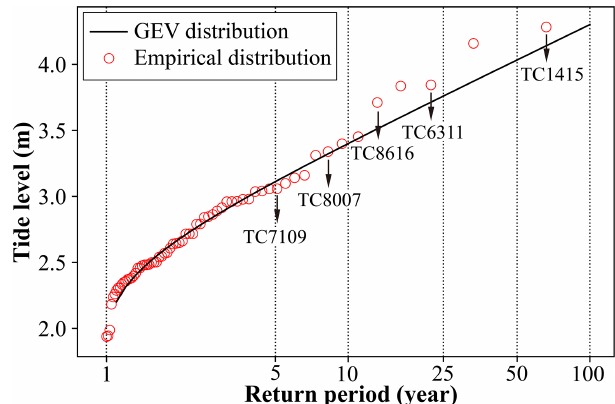
Figure 5. Storm tide at Xiuying gauge station as a function of return period based on GEV fitting (solid line).